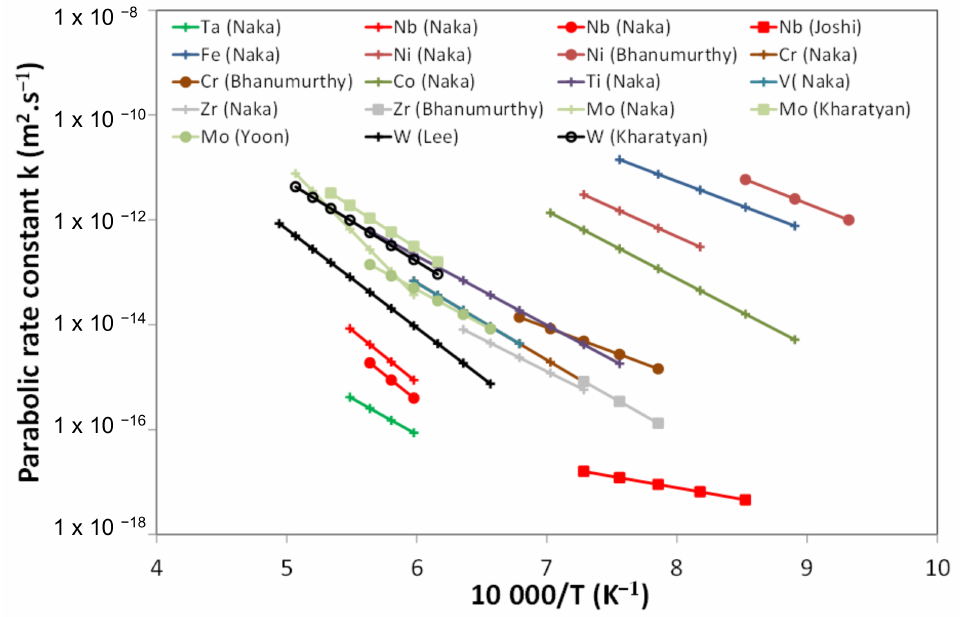
Figure 2. Parabolic rate constants ( k ) for growth of reaction layer between various metals and SiC as a function of temperature gathered from the literature